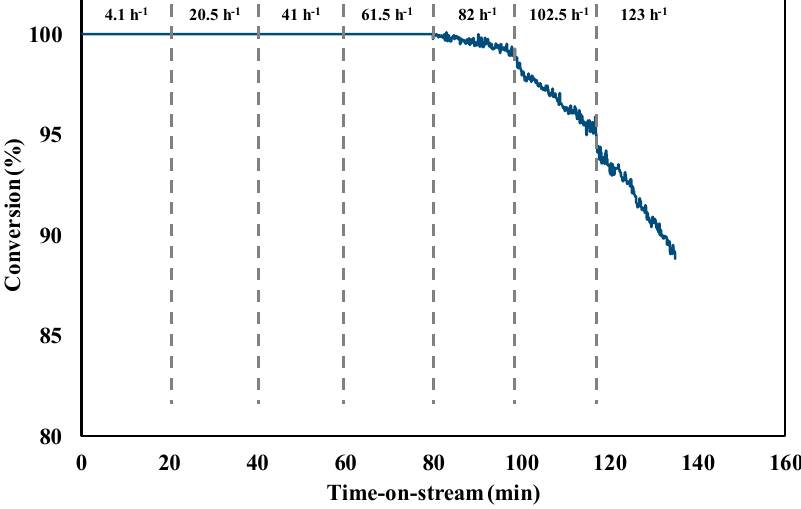
Figure 5. Results of stability test performed over Pt ‐ Ni/CeO 2 /SiO 2 catalyst at 500 °C, H 2 O/EtOH = 4, O 2 /EtOH = 0.5 and weight hourly space velocity (WHSV) = 4.1 h − 1 . Catalysts 2017 , 7 , 226 Decreased performances were observed for lower contact times, with a 99% of conversion after 20 min at 82 h − 1 and 89% after 20 min at 123 h − 1 (Figure 5). When the stability test was carried out at